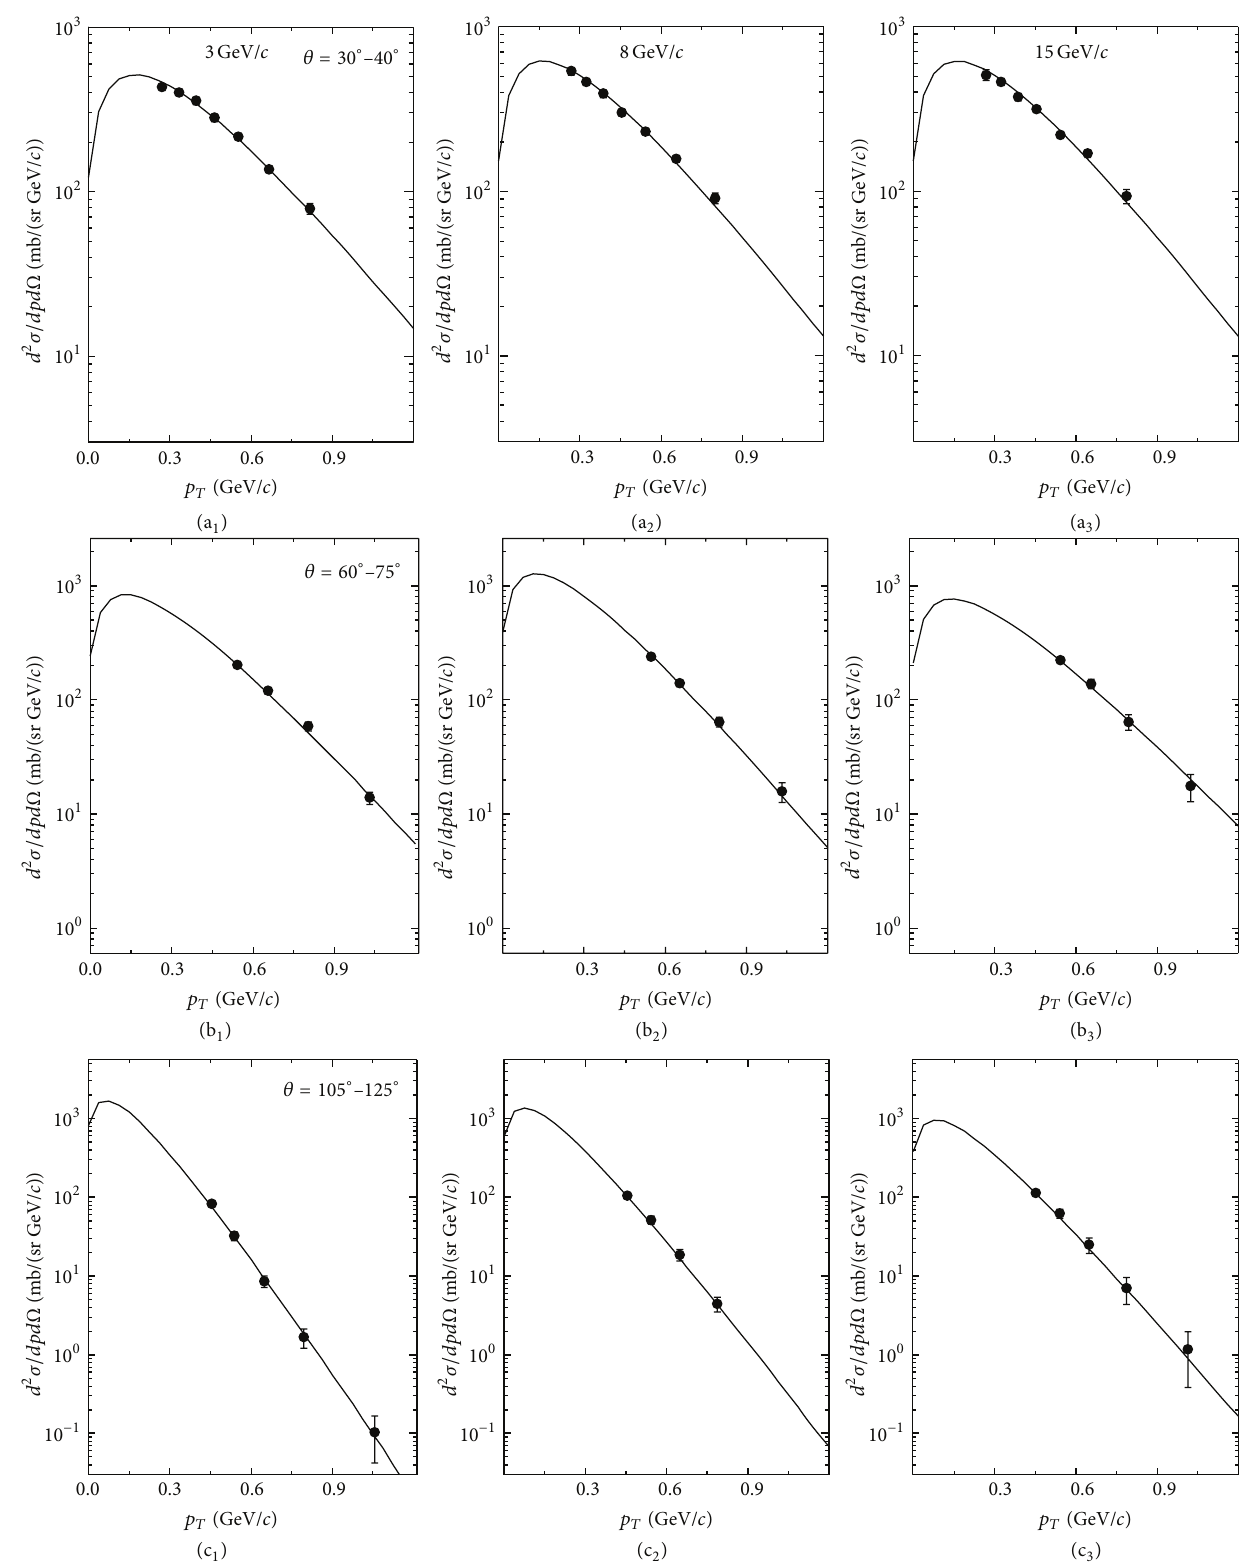
Figure 1: Transverse momentum of protons produced in 𝑝 + Cu collisions at 3, 8, and 15GeV/ c . The angular bins are 30 ∘ –40 ∘ , 60 ∘ –75 ∘ , and 105 ∘ –125 ∘ , respectively. The circles indicate the experimental data [9] and the curves indicate the results of the